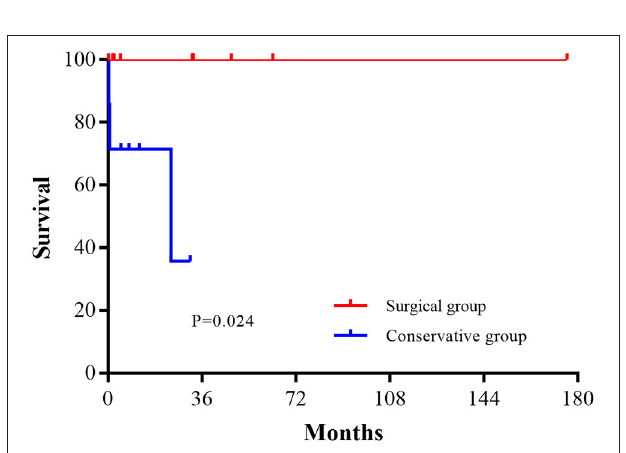
FIGURE 2 | Survival after surgical and conservative